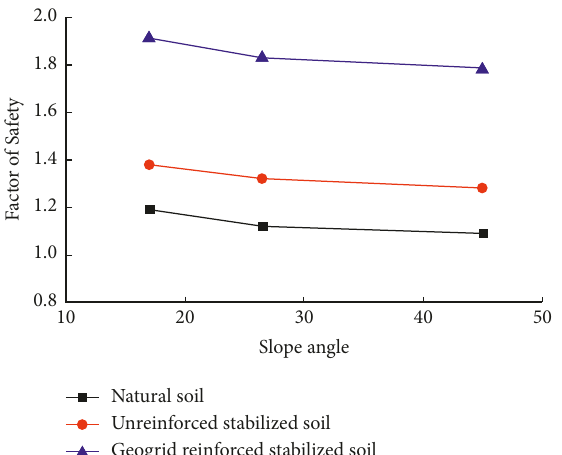
Figure 7: Comparison of factor of safety for embankment constructed of natural soil, unreinforced plastic stabilized soil and geogrid reinforced plastic stabilized soil.